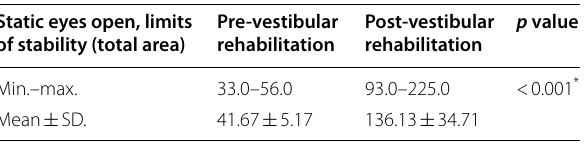
Table 8 Comparison of static eyes open, limits of stability before and after vestibular rehabilitation